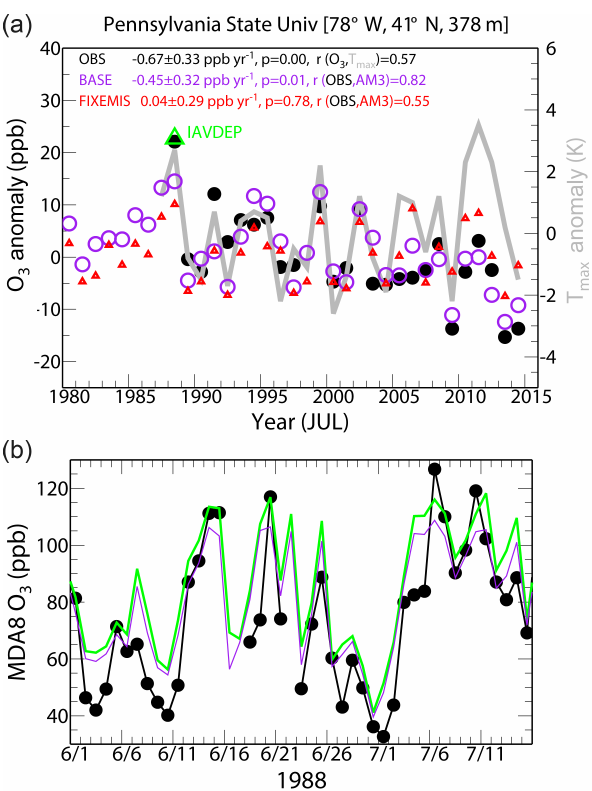
Figure 18. (a) Time series of July mean MDA8 O 3 anomalies (rel- ative to 1988–2014) at the Pennsylvania State University (PSU) CASTNET site as observed (black) and simulated by the GFDL- AM3 model with time-varying (purple) and constant anthropogenic emissions (red), along with observed anomalies in July mean daily max temperature (gray lines; right axis). The green triangle denotes the 1988 O 3 anomaly from a sensitivity simulation using BASE emissions but with 35% decreases in V d , O (IAVDEP). (b) Time 3 series of daily MDA8 O 3 at PSU from 1 June to 16 July in 1988 from observations (black), BASE (purple), and IAVDEP simula- tions